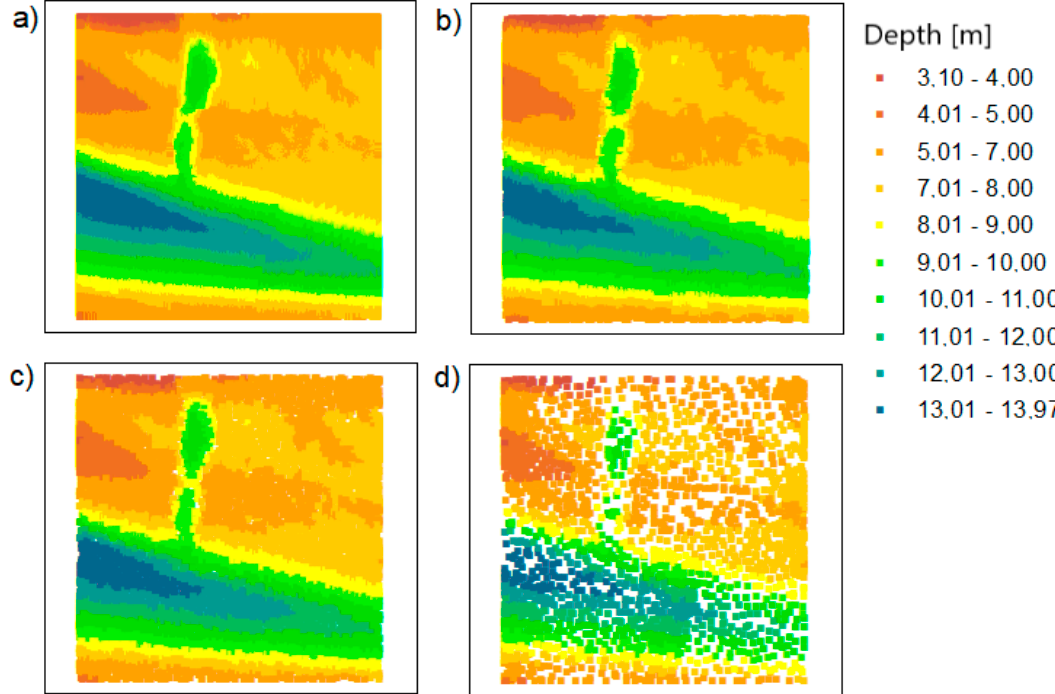
Figure 9. The datasets for the Inski canal area: ( a ) raw dataset; ( b ) integrated dataset for setting no. 1; ( c ) integrated dataset for setting no. 2; ( d ) integrated dataset for settings no. 3.